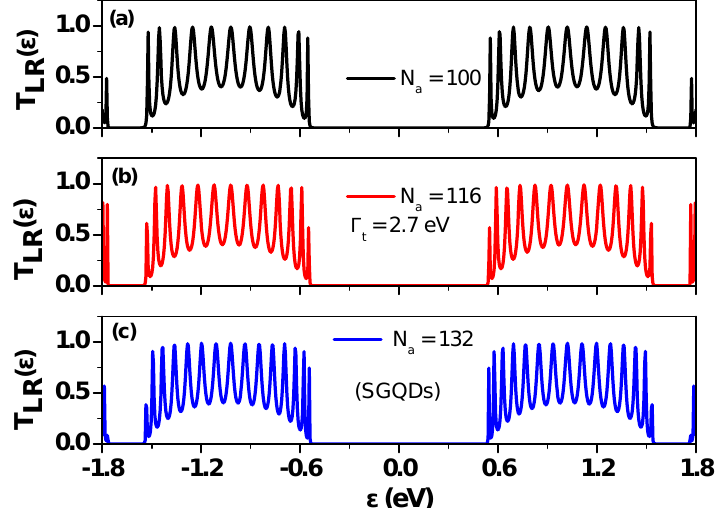
Figure 9. Transmission coefficient of SGQD with N z = 5 for various N a values as a function of energy ε . Γ t = 2.7 eV. Here, N a = 12 + 8 × N QD , where N QD is the number of GQDs in the interior region of the structure, and they are sandwiched between two smaller GQDs of N a = 6 connected to electrodes. In ( a – c ) we consider cases with N a = 100,116, and 132 that correspond to N QD = 11,13, and 15, respectively. For N a = 116 and N a = 132, the lengths of SGQDs are 12.2 nm and 13.9 nm, respectively.